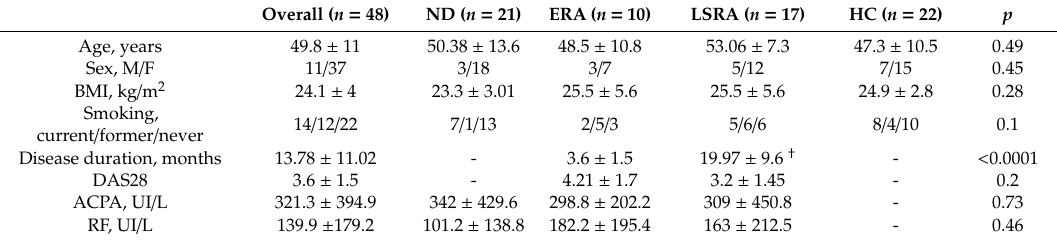
Table 1. Demographic, clinical features and autoantibodies of enrolled